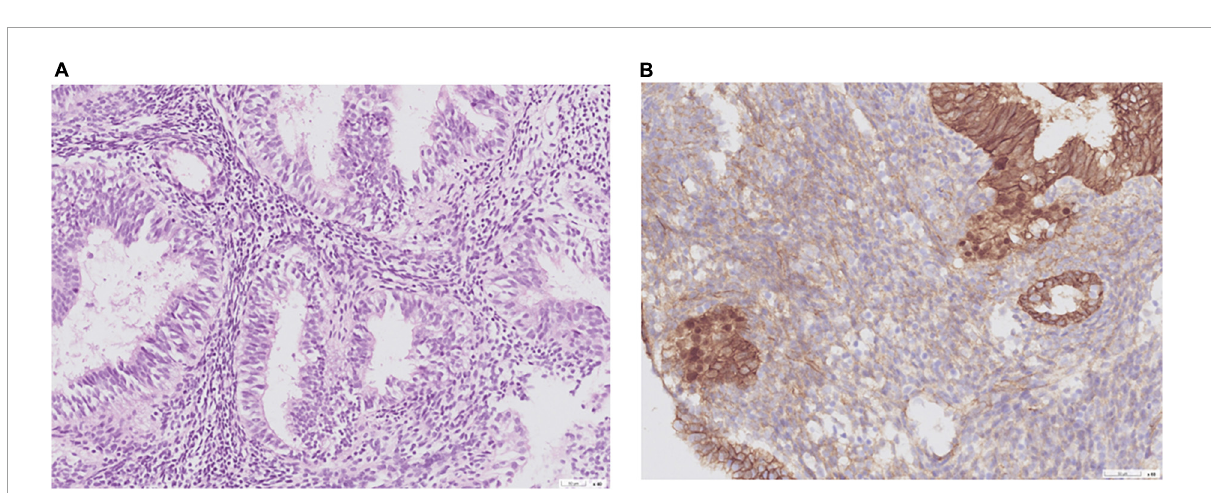
FIGURE3 Representative histological images obtained from a woman with non-atypical endometrial hyperplasia (patient EH19). (A) Hematoxylin and eosin stain; (B) CTNNB1 immunostaining. A CTNNB1 mutation was identified in the endometrial lavage sample but not in the corresponding tissue specimen. A review of pathological slides revealed suspected foci of atypia and prompted follow-up surveillance. This case illustrates the potential clinical impact of endometrial lavage sequencing.